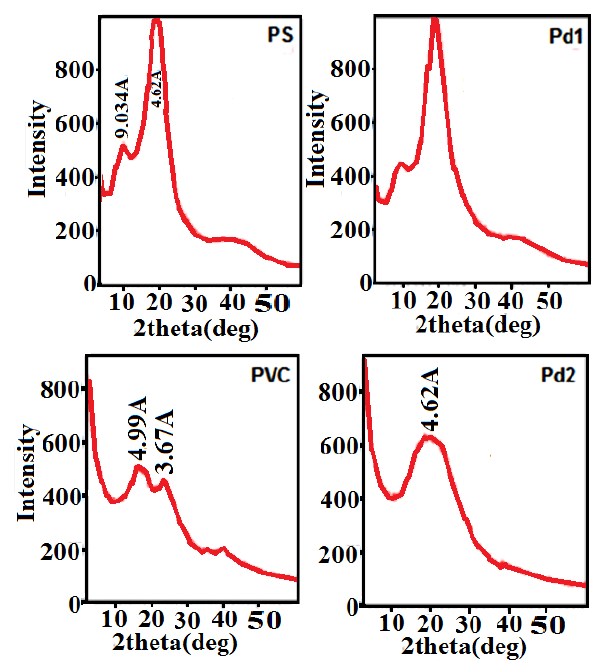
Figure 3: X ray diffraction (XRD) of PS, Pd1 (PS/PVA:10/90),PVC and Pd2